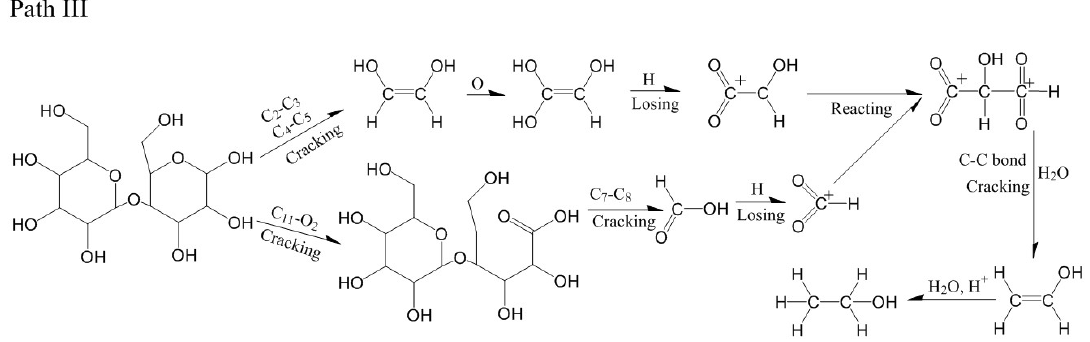
Figure 16. Relevant path III of ethanol generation at 3000 K.